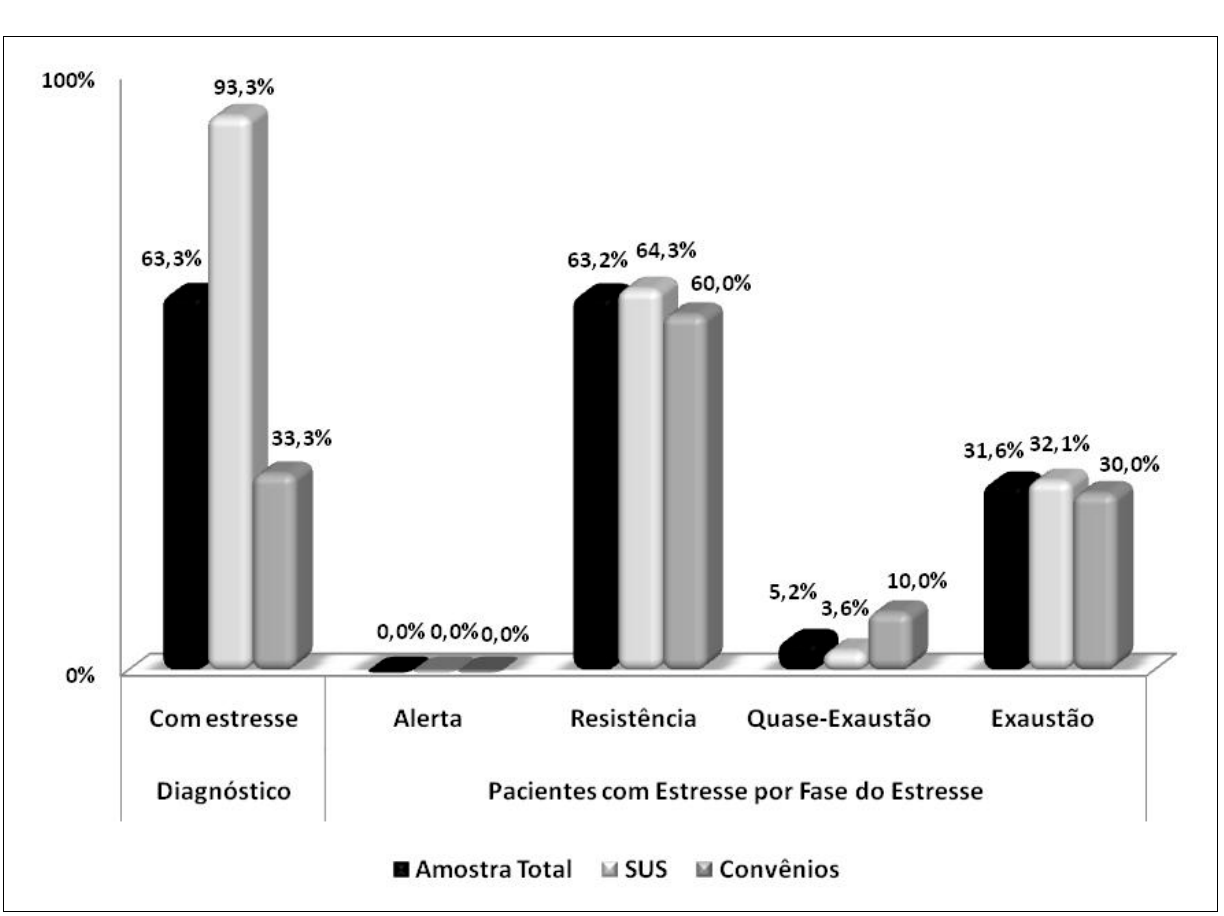
Figura 1 . Diagnóstico e fases do estresse em pacientes no pré-operatório de colecistectomia segundo a amostra total, SUS e